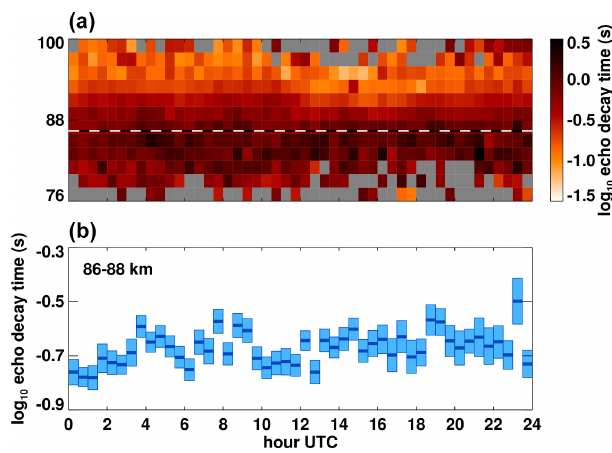
Figure 8. Shown are 30min averages of echo decay times of under- dense meteors detected by NSMR in 2km bins. The dashed line in panel (a) shows the height of the range bin that PMSE return is max- imum. Panel (b) shows the 30min averaged decay time of meteors around the PMSE height. Shaded boxes denote the 95% confidence